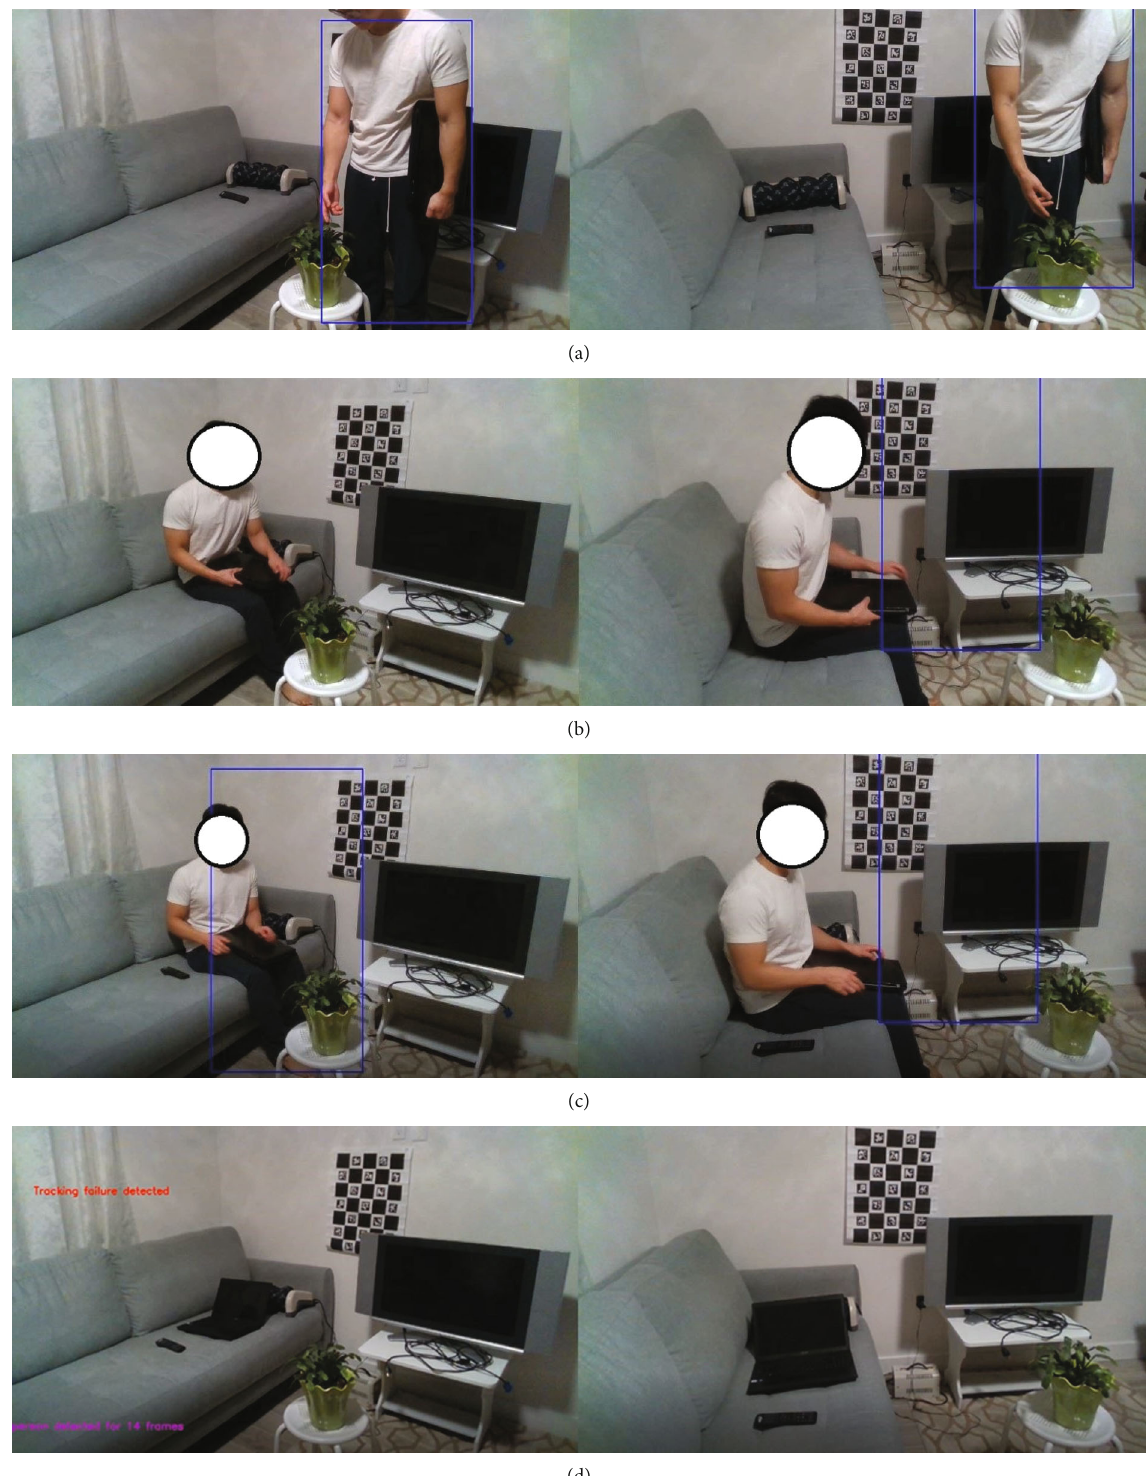
Figure 6: Sequence of activities associated with the fi rst case study when the presence and then the absence of the person are detected in the monitoring area. As a part of the privacy protection feature of the method, the data collection applies when the absence of older adult in the monitoring area is detected. The blue rectangle is the region of interest de fi ned as a part of the movement tracking